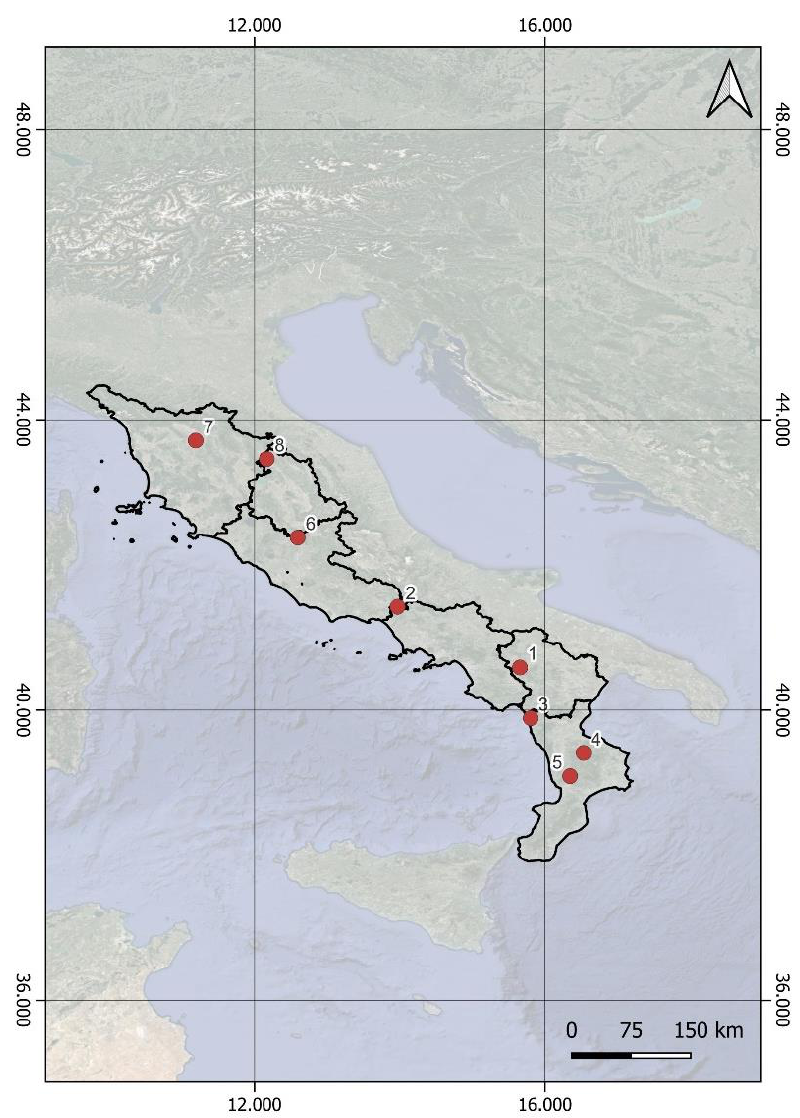
Figure 1. Areas of interest refer to the IDs in Table 1. Table 1. Summary table of wildfire events considered as case studies. Region Year Area (ha) Approx.